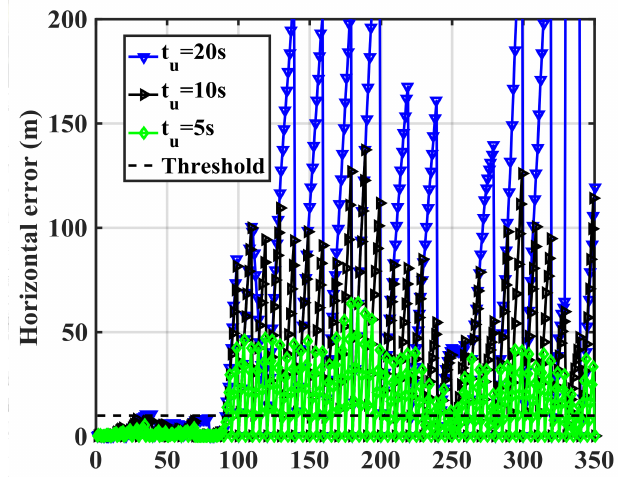
Figure 9. RIO horizontal errors for various update intervals ( t u ) in the spoofing case using the cellphone MEMS